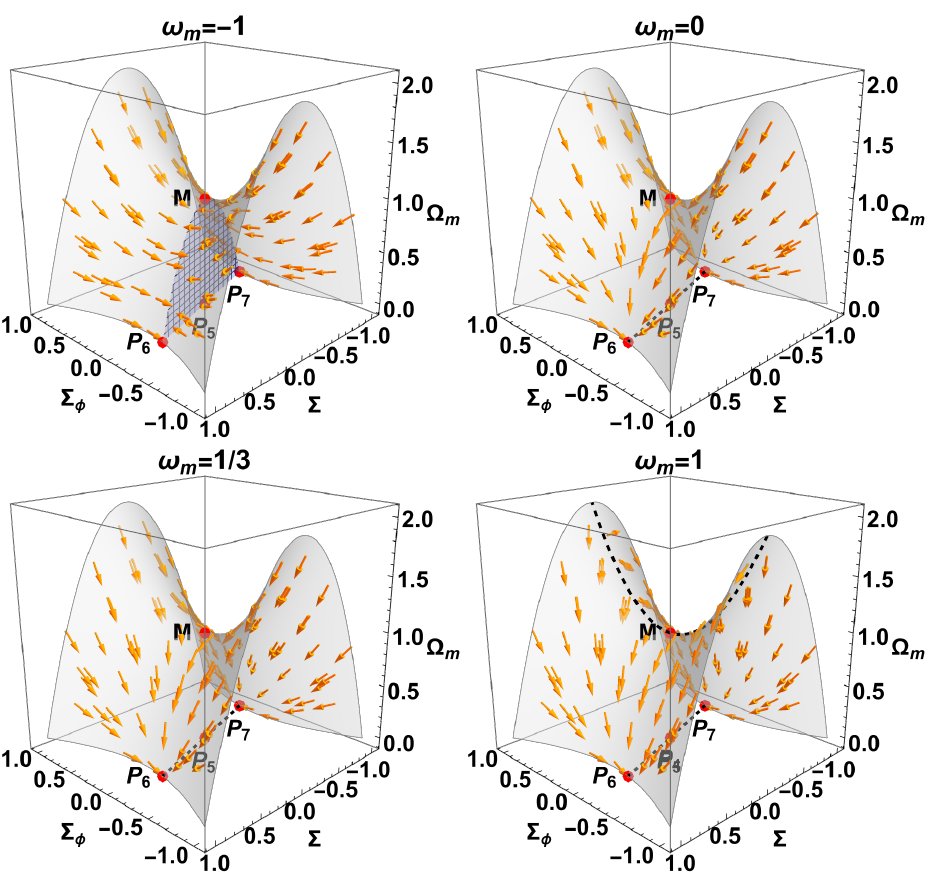
Figure 6. The 3D phase plot for System (82), (83), and (84) for (cid:101) = − 1, µ = 2, and different values of ω m